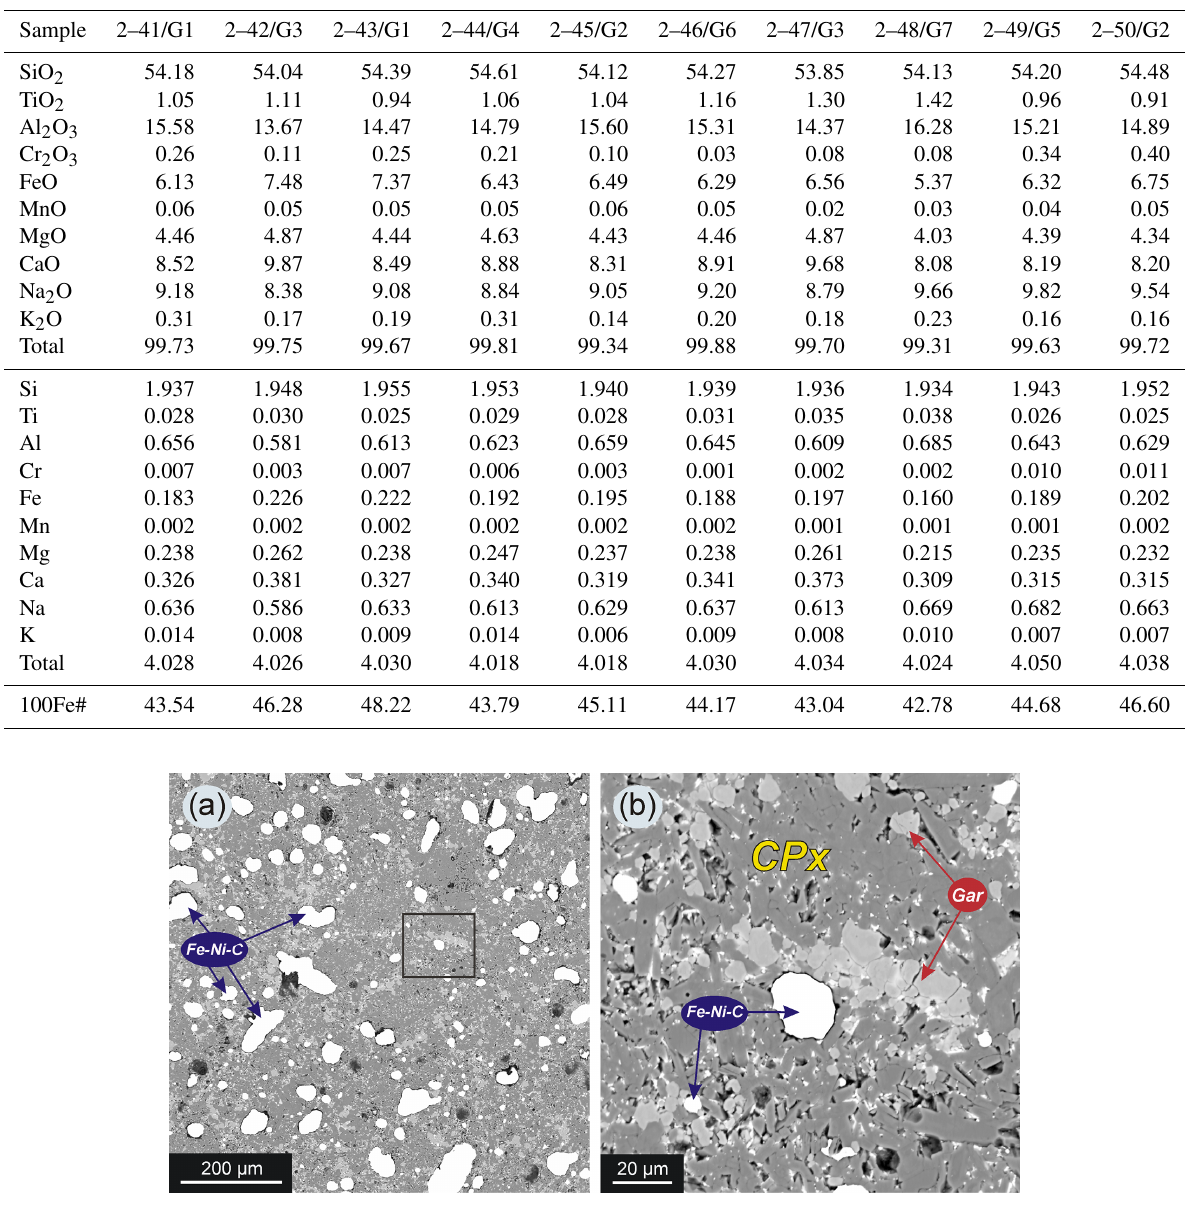
Figure 6. SEM images of synthetic silicates from the upper part of the chamber (assembly configuration as in Fig. 1f) from experiment 2–47 with 15wt% basalt addition to the system: (a) general view, Fe–Ni–C – quenched metal (bright spots); (b) magnified view of area shown with a black square in (a) – silicates are represented by garnet (Gar) and clinopyroxene (Cpx). Note that metal drops in the silicate matrix are not